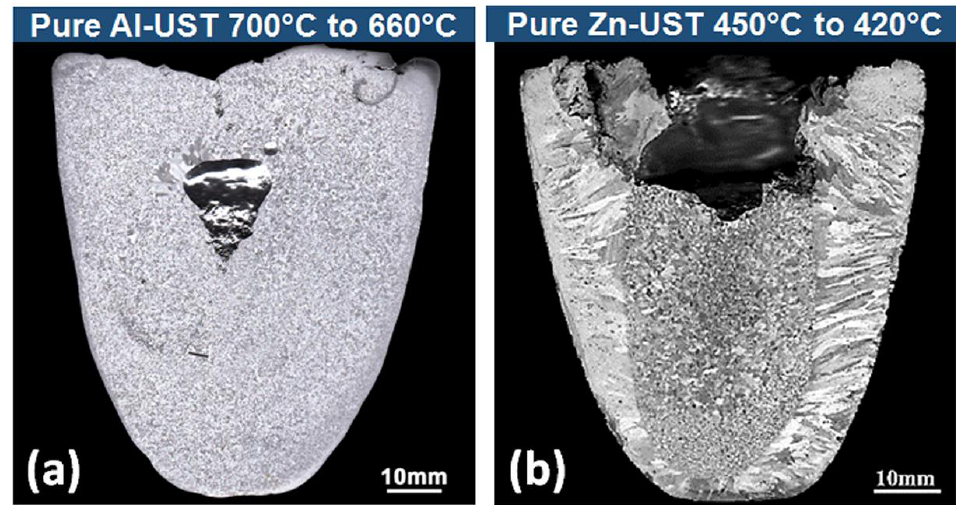
Figure 13. Macrostructures of ultrasonically treated ( a ) pure Al and ( b ) pure Zn.